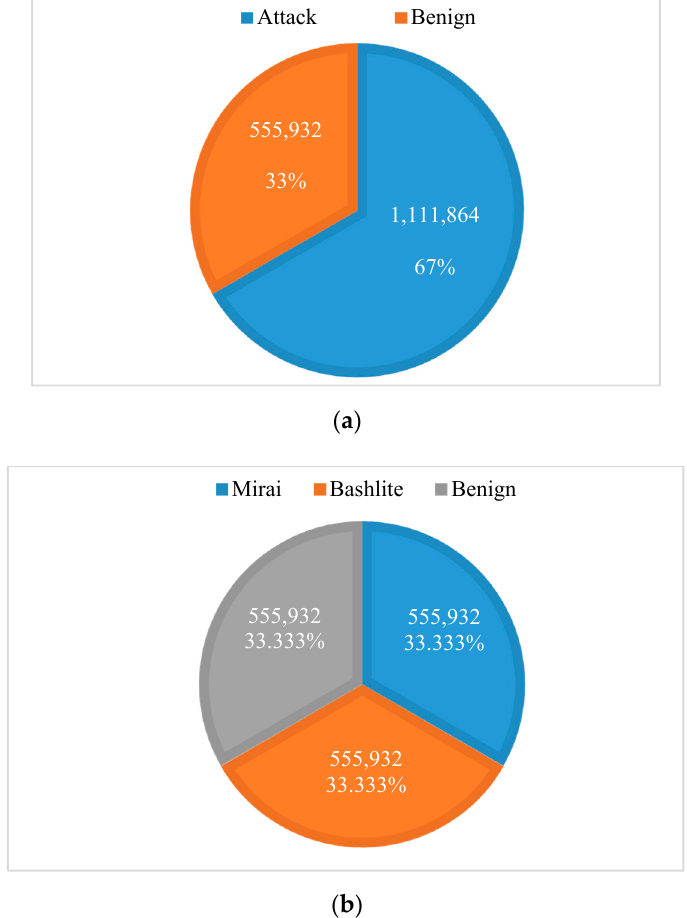
Figure 4. The distribution of instances in the dataset: ( a ) the distribution of instances according to the Mirai, Bashlite, and benign classes; ( b ) the distribution of instances according to attack and benign classes.